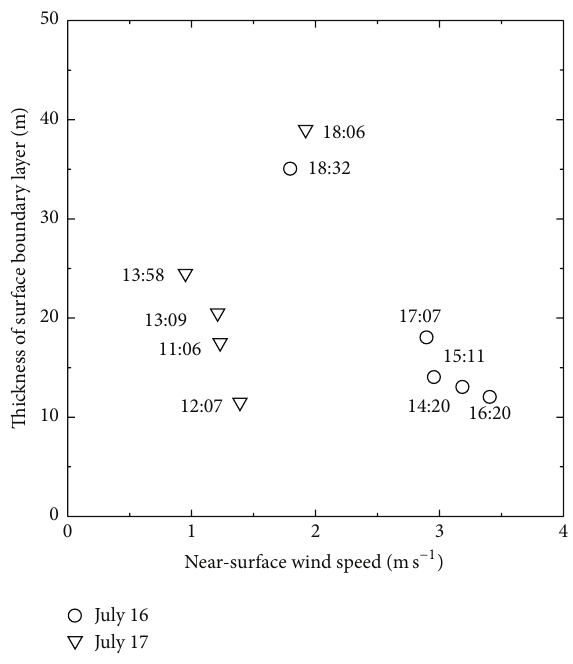
Figure 4: Relationship between 𝛿 and 𝑈 𝑎(0.12 m ) [17].